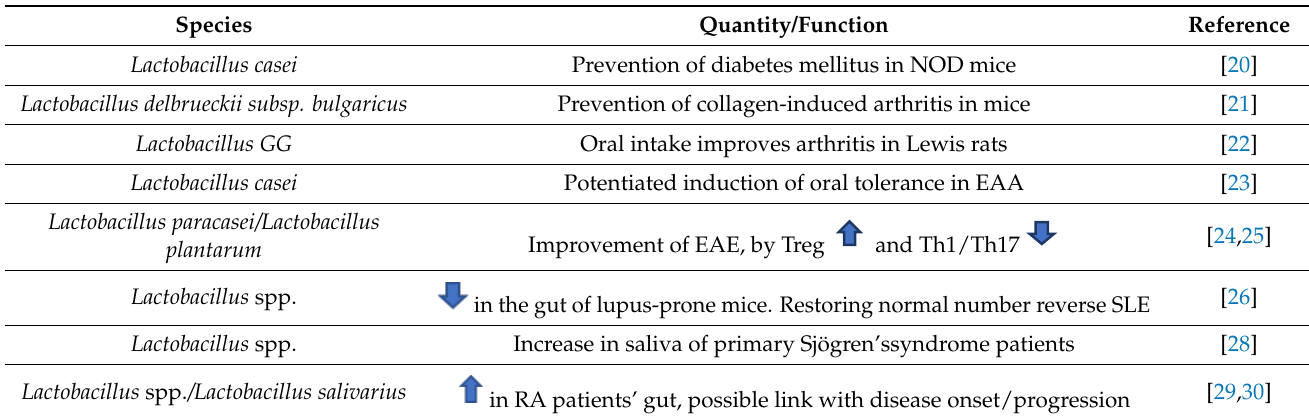
Table 1. Controversial role of Lactobacillus spp . in systemic immune-mediated inflammatory diseases.